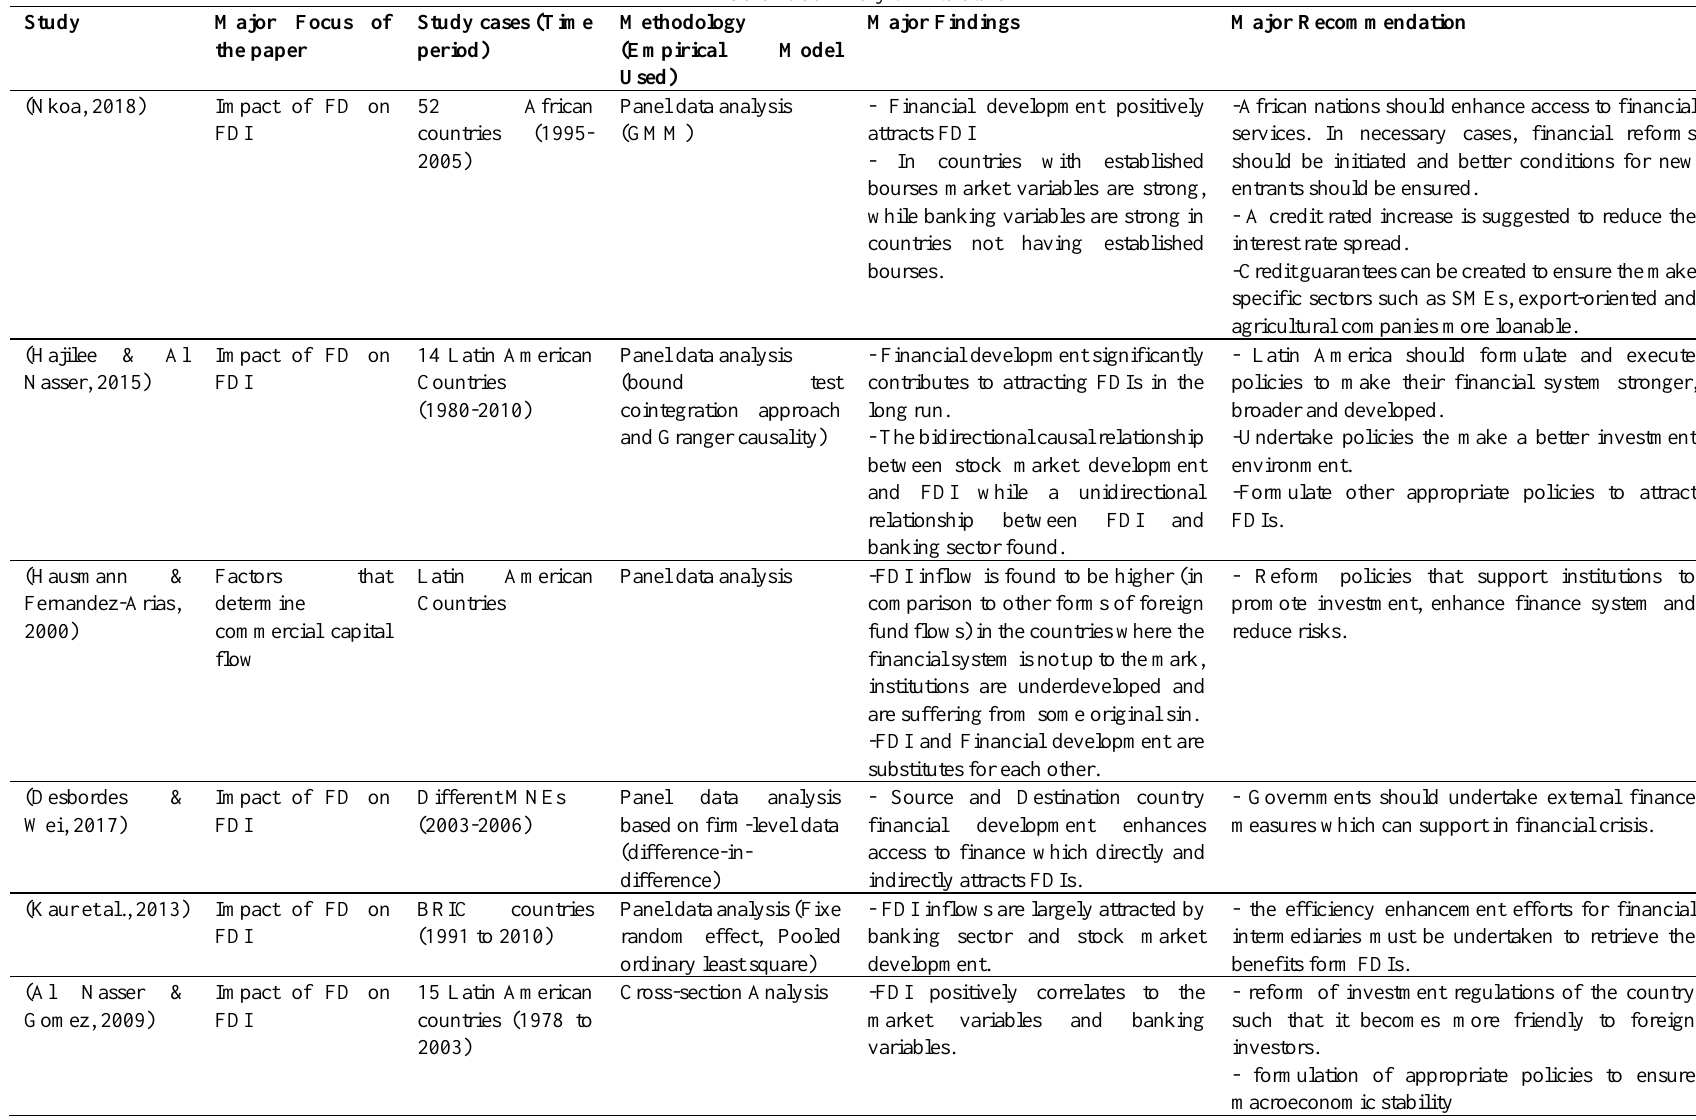
Table 1: Summary of